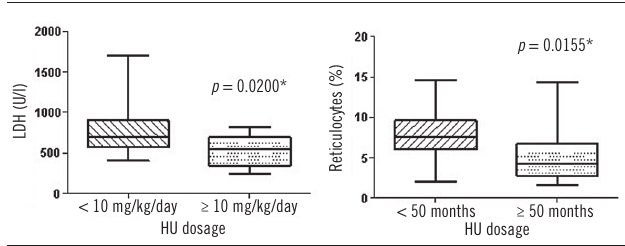
figurE 2 − Hemolysis biomarkers according to use of HU Comparing means of the hemolysis parameters in patients with AF with HU < 10 mg/kg/day, n = 24; ≥ 10 mg/kg/day: n = 21, and n ≤ 50 months = 23, n ≥ 50 months = 22. The p -value was obtained by an unpaired t -test and the Mann-Whitney test. HU dose calculated for an average weight of 70 kg per person, with p < 0.05*; HU: hydroxyurea; LDH: lactate dehydrogenase.